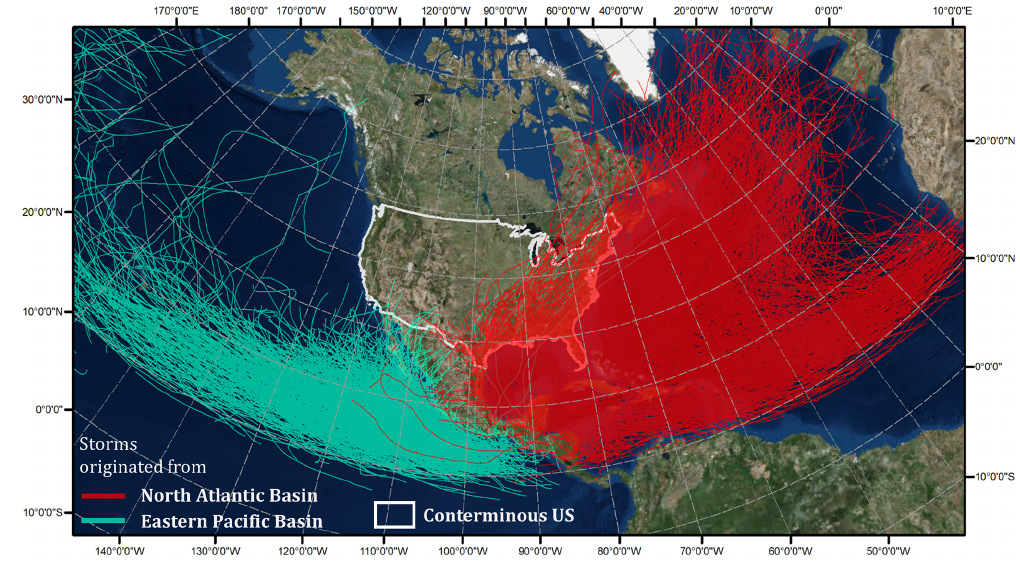
Figure 1. Historical storm tracks from the North Atlantic Basin (in red) and from the Eastern Pacific Basin (in green). Basemap sources: Esri,